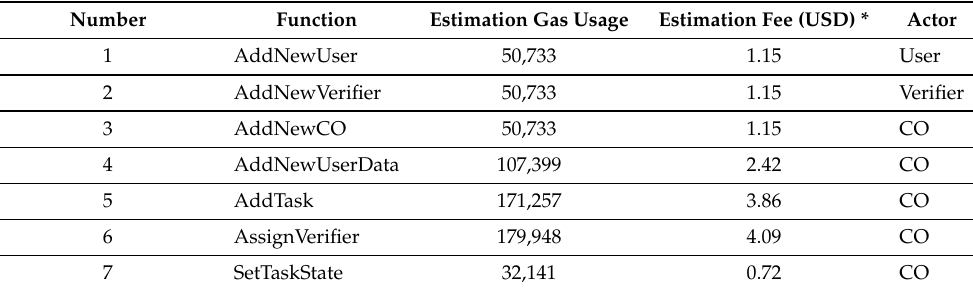
Table 5. Estimation of gas usage for each function in the smart contract. * Data calculated from ETH Gas Station [28] on 31 October 2022. The average gas price at that time is 14 Gwei.